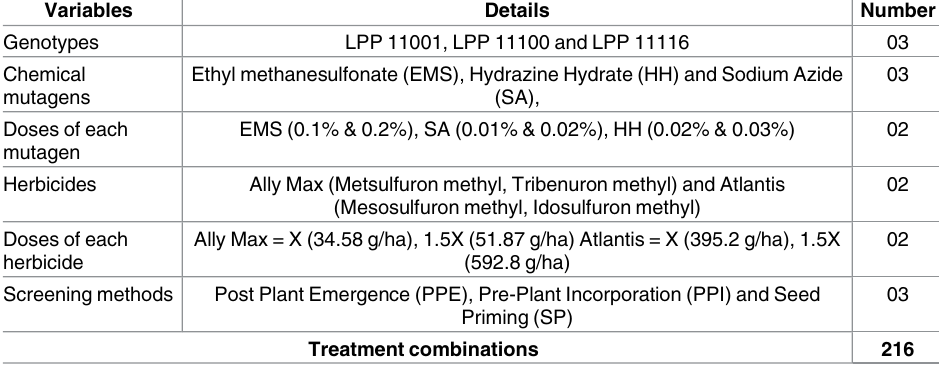
Table 2. Experiment detail consisting of variables, their levels and number.